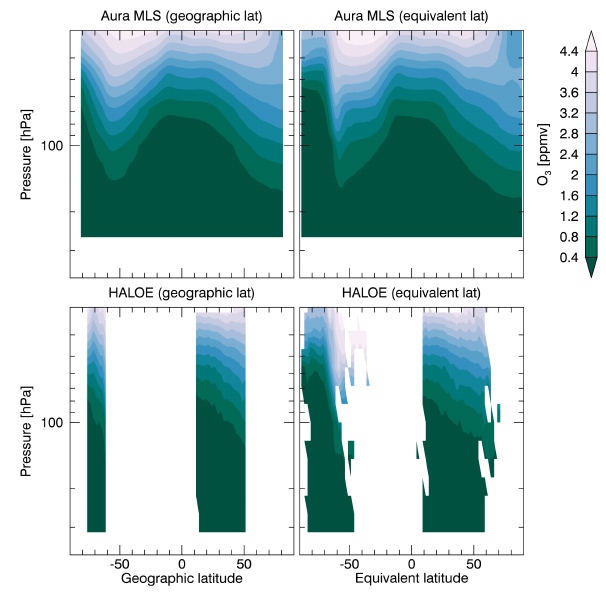
Figure 10. Ozone height vs. latitude plots on geographic latitude (left column) and equivalent latitude grids (right column), for Octo- ber 2004. Increased data coverage and increased depth of Antarctic ozone depletion are apparent in the equivalent latitude gridded